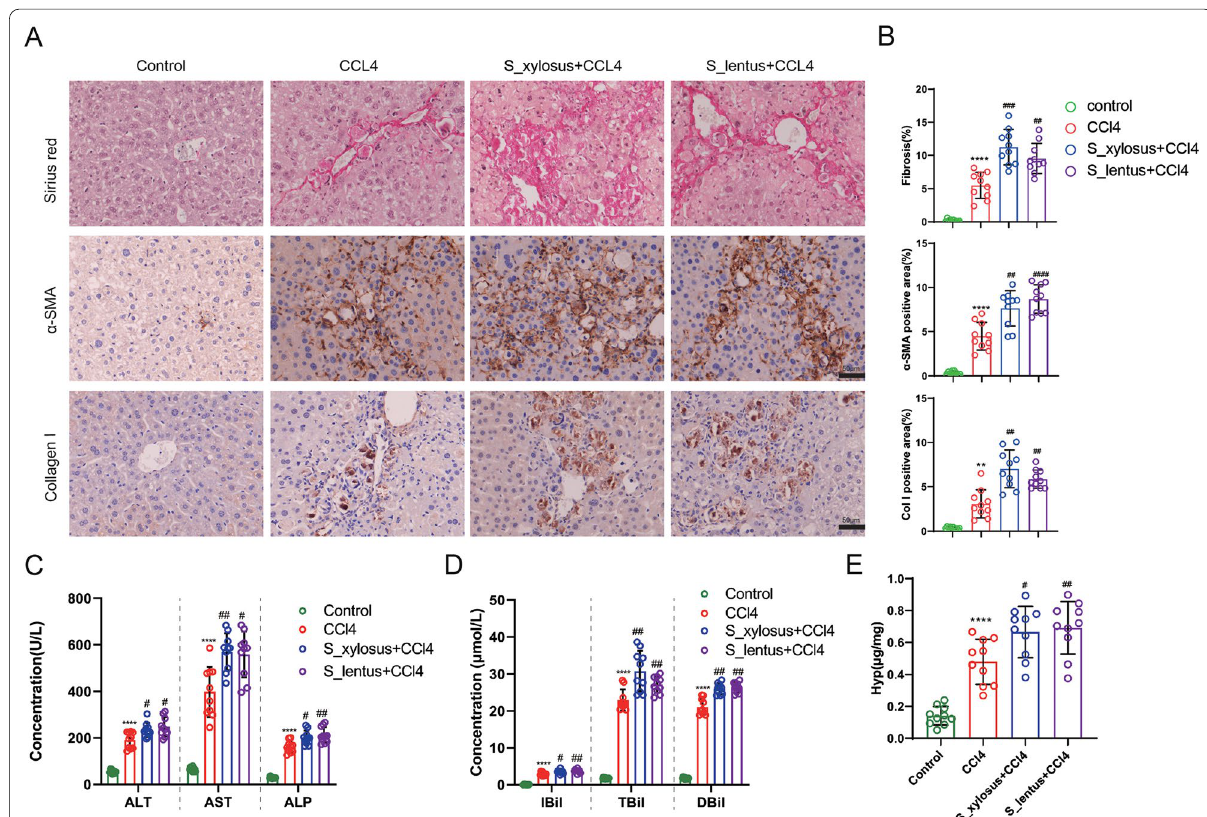
Fig. 3 Regulation of Staphylococcus_xylosus and Staphylococcus_lentus on the process of liver fibrosis in mice. The pure cultures (10 9 CFU) of the three kinds of gut microbiota ( Staphylococcus_lentus , Aerococcus_viridans and Staphylococcus_xylosus ) were given to mice by gavage to make them become the dominant microflora in the intestine, and then the liver fibrosis model of mice was induced by the intraperitoneal injection of CCl 4 (0.5 µL/g). A , B Sirius red staining and immunohistochemical assays were conducted to assess the degree of liver fibrosis in mice (N 10, = scale bar 50 µm), Brown-Forsythe and Welch ANOVA with Games-Howell’s post-hoc. C Different detection kits were applied to measure the = concentrations of ALT, AST and ALP in mouse blood samples, Brown-Forsythe and Welch ANOVA with Games-Howell’s post-hoc. N 10. D The = concentrations of IBiL, TBiL and DBiL in mouse blood samples were assessed, one-way ANOVA with Tukey’s post-hoc for IBil, Brown-Forsythe and Welch ANOVA with Games-Howell’s post-hoc for TBil and DBil. N 10. E Comparison of the hydroxyproline (Hyp) level using a commercial kit. = N 10. ** P < 0.01, **** P < 0.0001 vs. Control. # P < 0.05, ## P < 0.01, ### P < 0.001, #### P < 0.0001 vs. CCl 4 . S_xylosus : Staphylococcus_xylosus , S_lentus : =